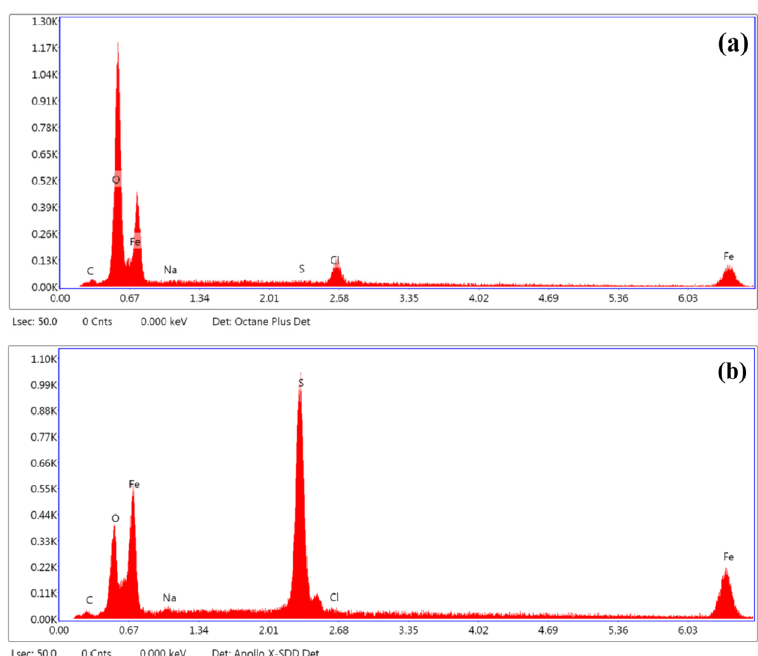
Figure 10. Elemental analysis (EDS) spectra: ( a ) bare electrode, ( b ) S8-coated electrode.